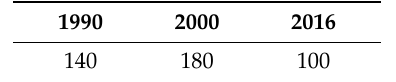
Table 4. YABs at Myeong Dong Catholic Church 12 .